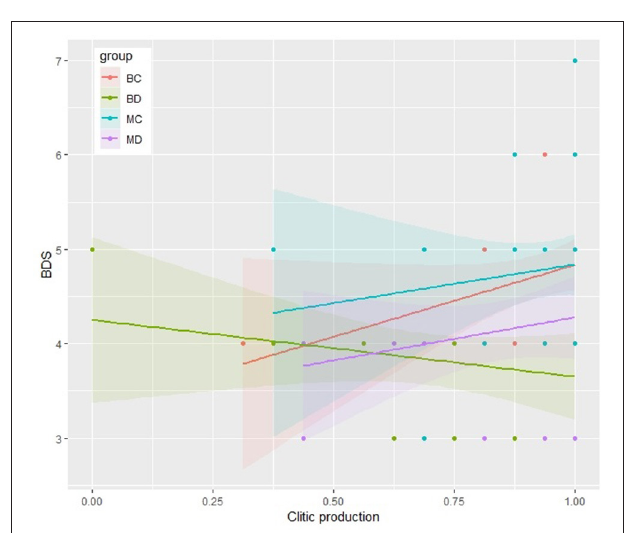
FIGURE 3 | Scatter plot representing the relationship between production of target clitics in the Present Perfect and BDS for each